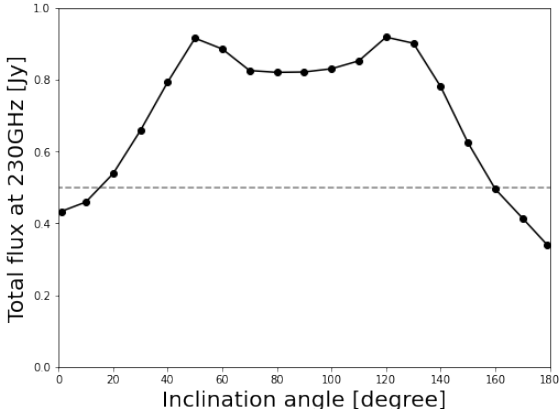
Figure 3. Diagram of the total (image-integrated) fluxes at 230 GHz for different inclination angles, assuming the distance to M87. Gray dash line corresponds to 0.5 Jy.